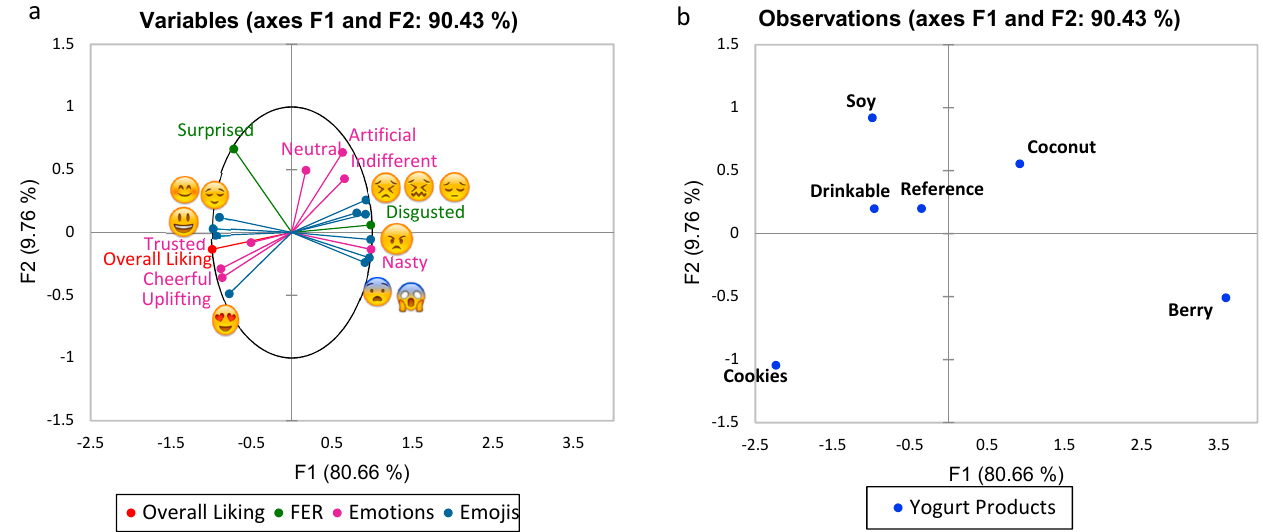
Figure 4. Multifactor analysis for a combination of check-all-that-apply (CATA) emotions, check-all-that-apply (CATA) emojis and facial expression recognition (FER) with overall liking (( a )-variables, ( b )-yogurt products).